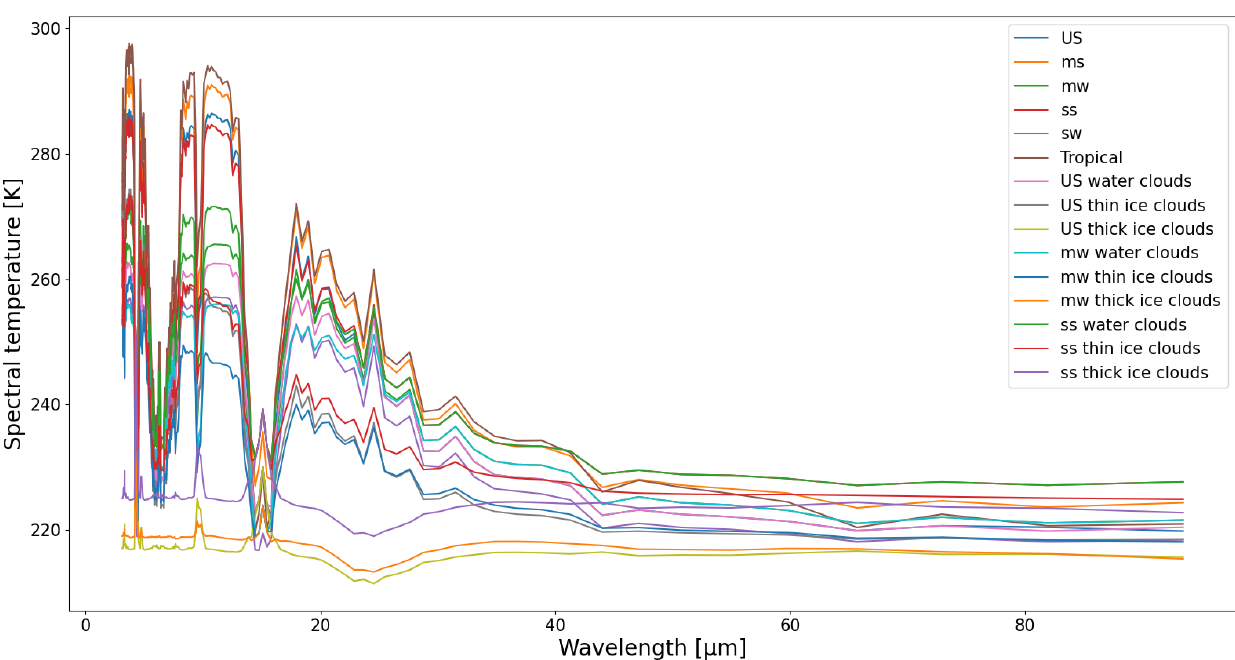
Figure 8. Spectral brightness temperature as function of wavelength for simulated scenes, listed in Table